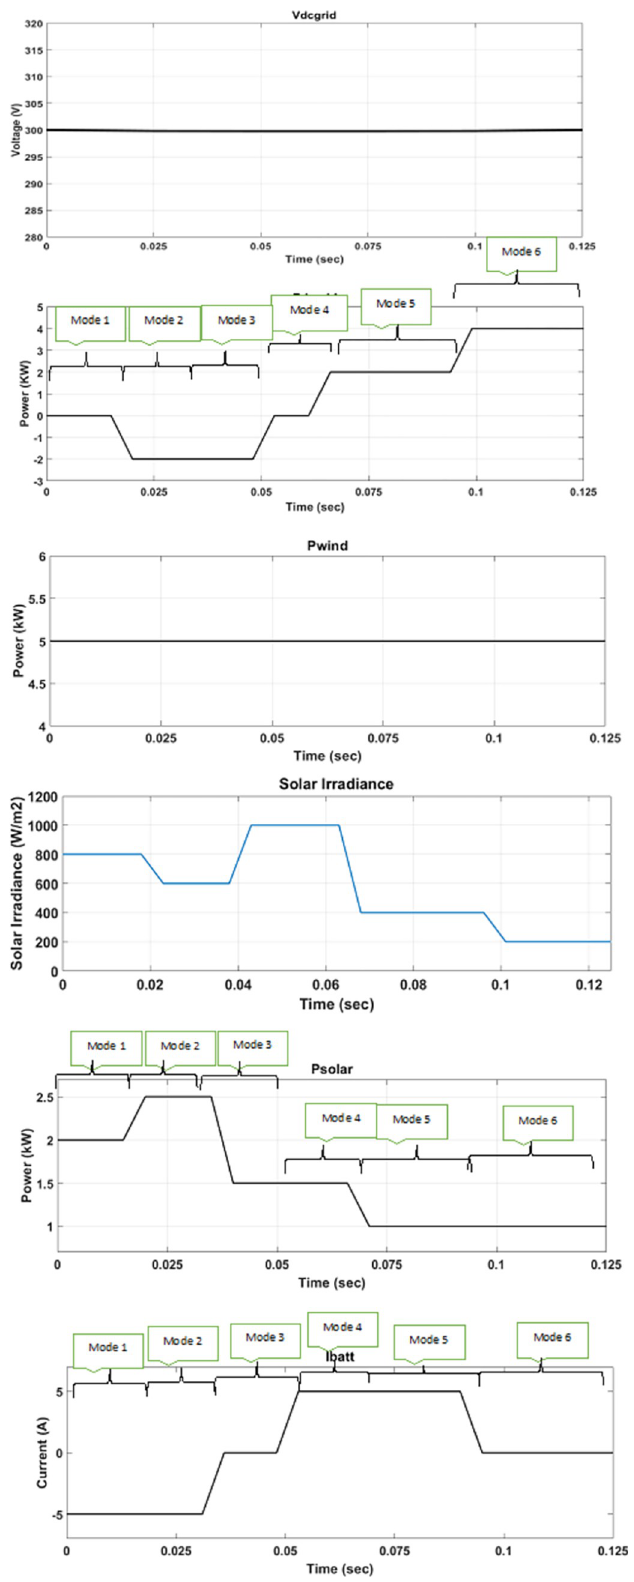
Fig 18. Grid-connected mode under variable DRES generation and load. https://doi.org/10.1371/journal.pone.0278110.g018 PLOS ONE | https://doi.org/10.1371/journal.pone.0278110 January 20,